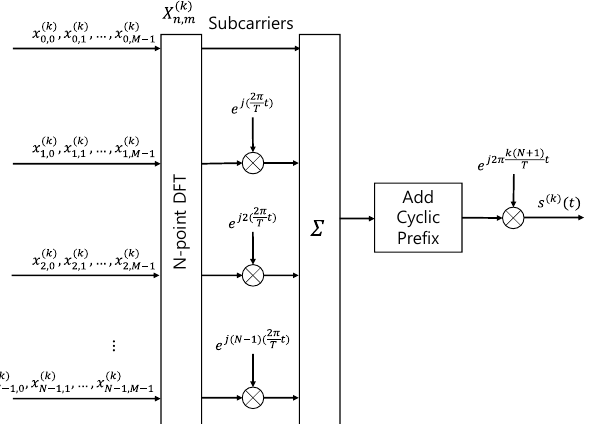
Figure 1. Structure of the k -th user’s single carrier frequency division multiple access (SC-FDMA)